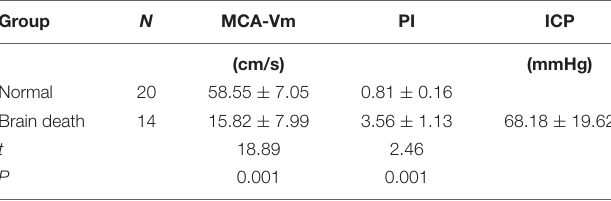
TABLE 1 | Parameters of TCD in brain death group and normal group.